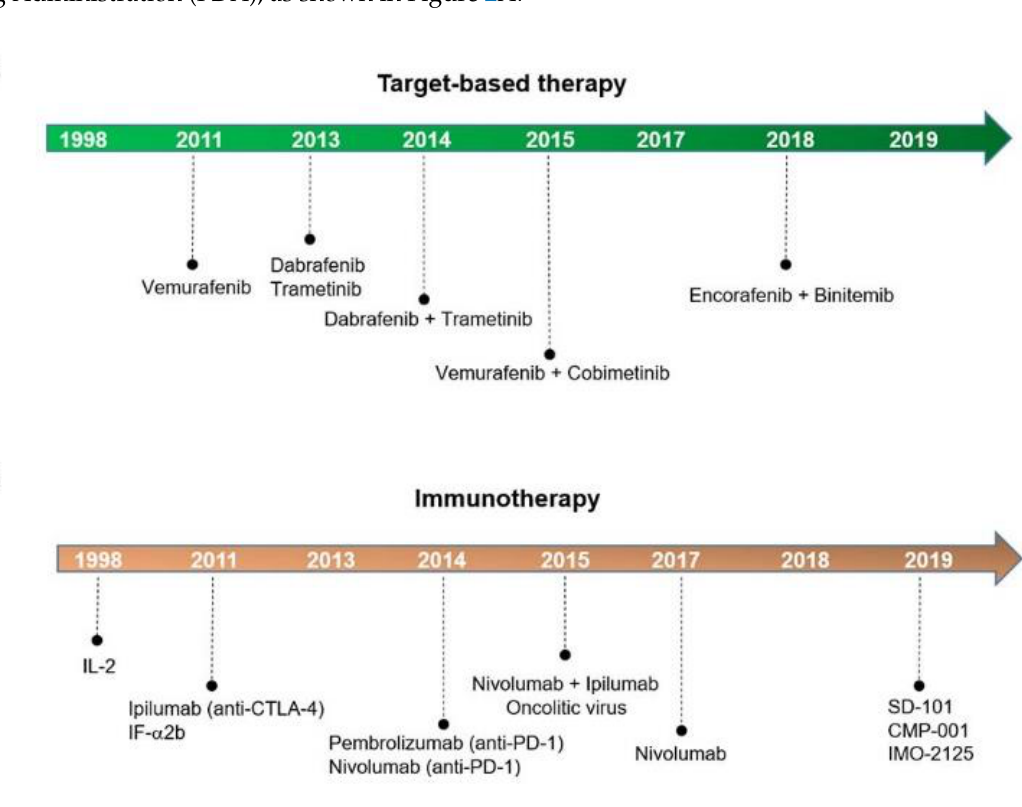
Figure 2. Melanoma treatment advances. Target-based therapy ( A ) and immunotherapy drugs ( B ) FDA-approved .